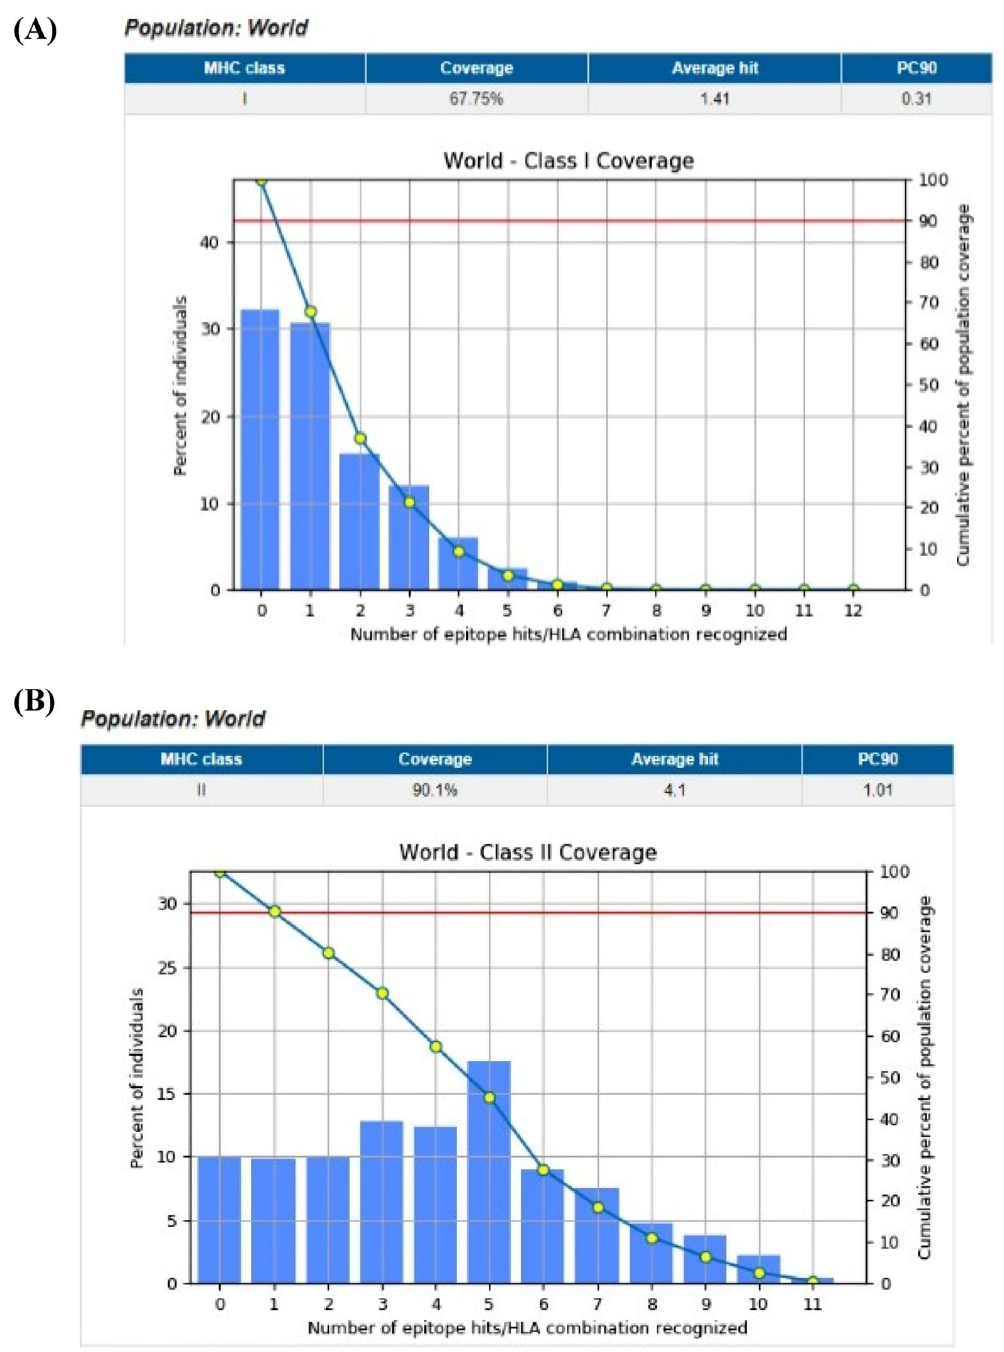
Figure 3. ( A ) Shows the global coverage for the top 10 MHC-I peptides, ( B ) Shows the global coverage for the top 10 MHC-II peptides.